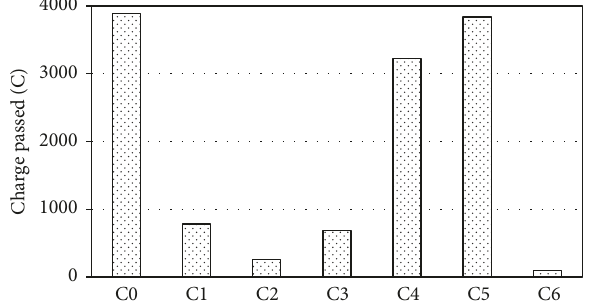
Figure 9: Charge passed for coated concrete